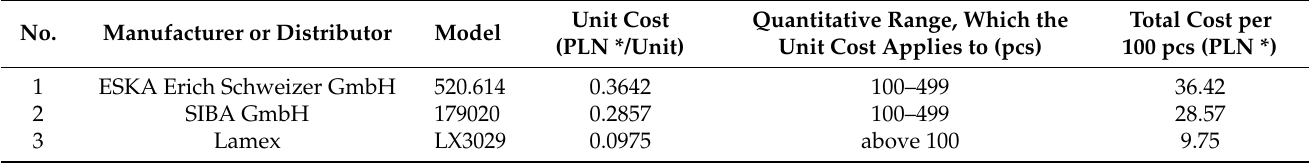
Table 1. Price comparison of the miniature fuse-links subjected to destructive testing.